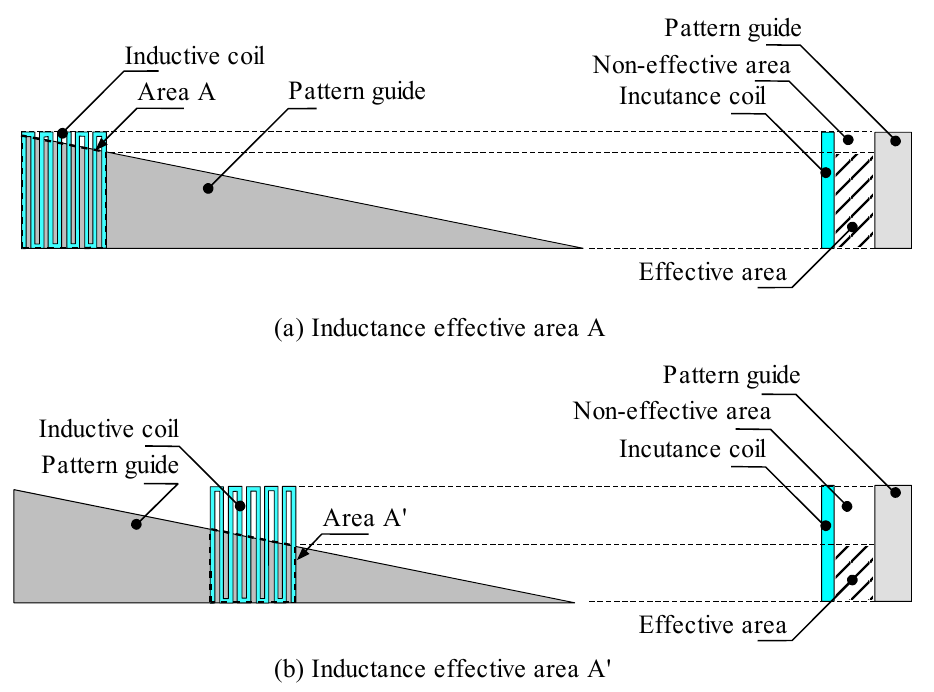
Figure 2. Comparison of inductance effective area at difference position of inductive